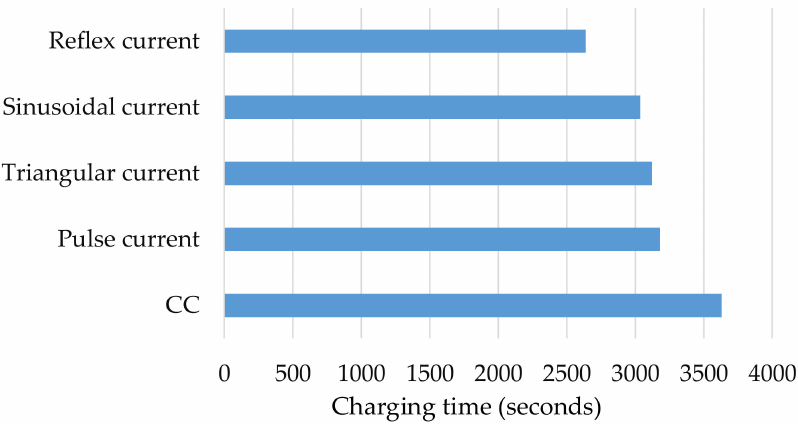
Figure 13. Charging duration comparison between five charging methods.